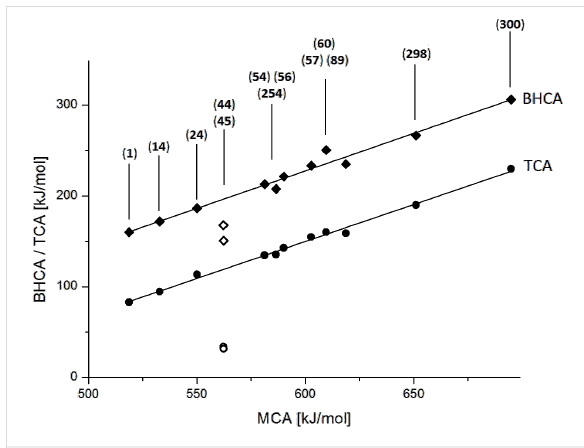
Figure 9: Comparison of MCA, BHCA, and TCA values of selected Lewis bases.